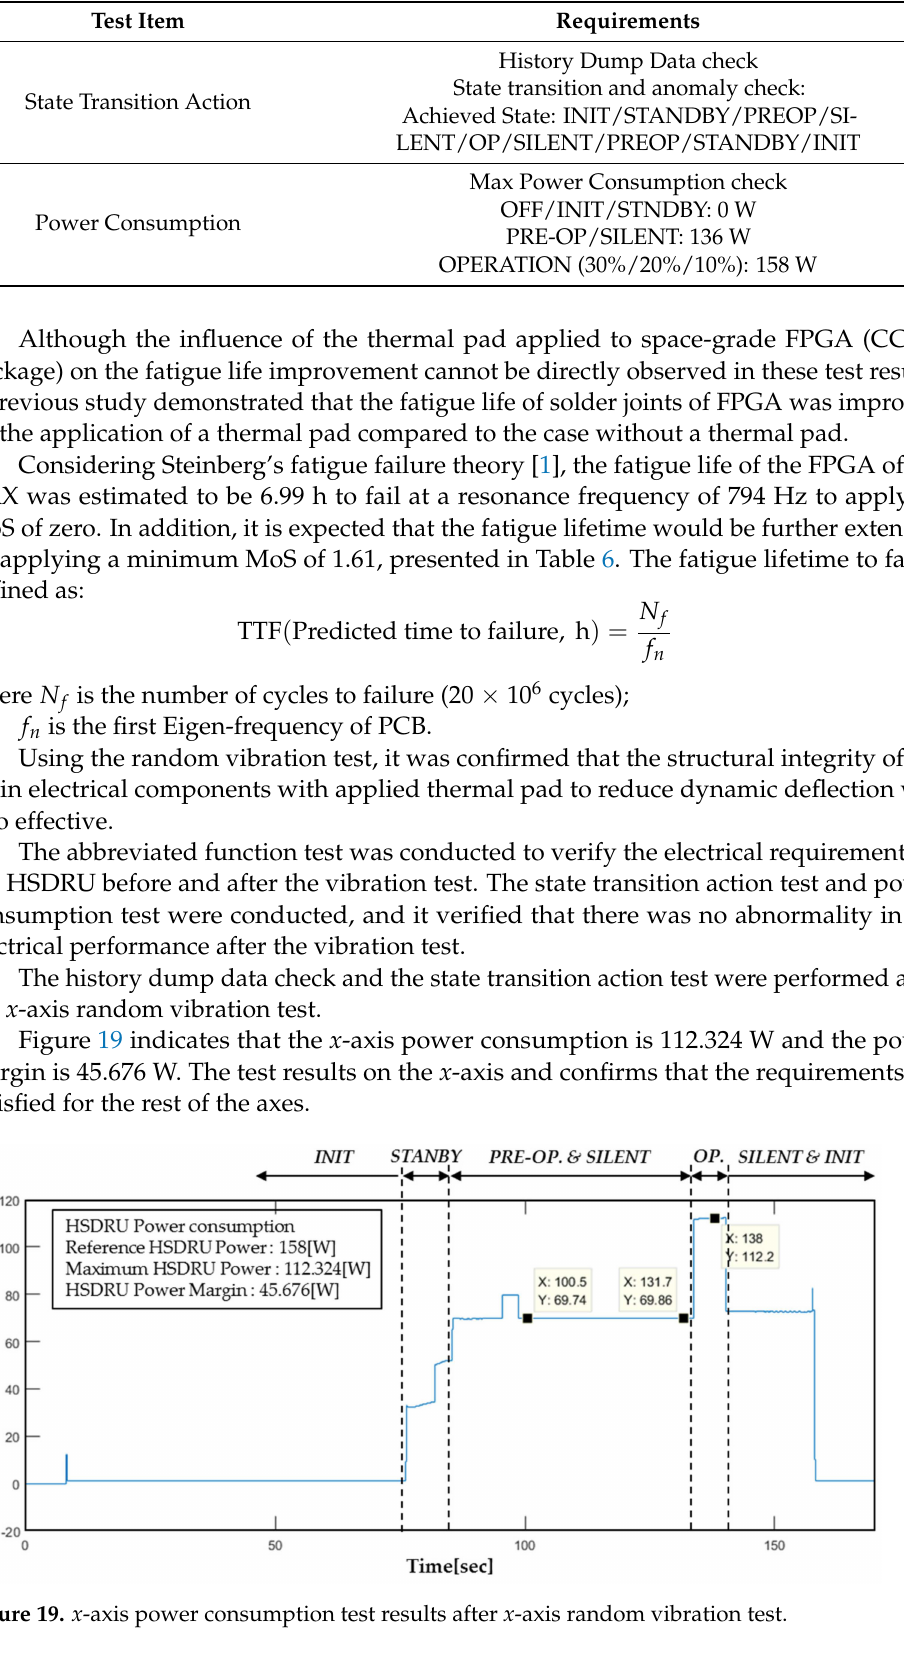
Table 11. Abbreviated function test.